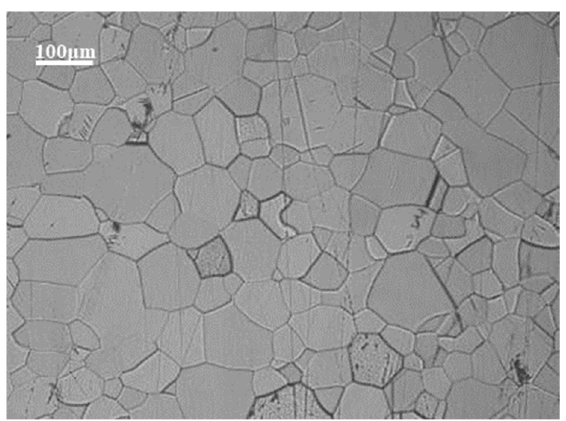
Figure 10. The preferred 860 °C open rolling annealing organization.